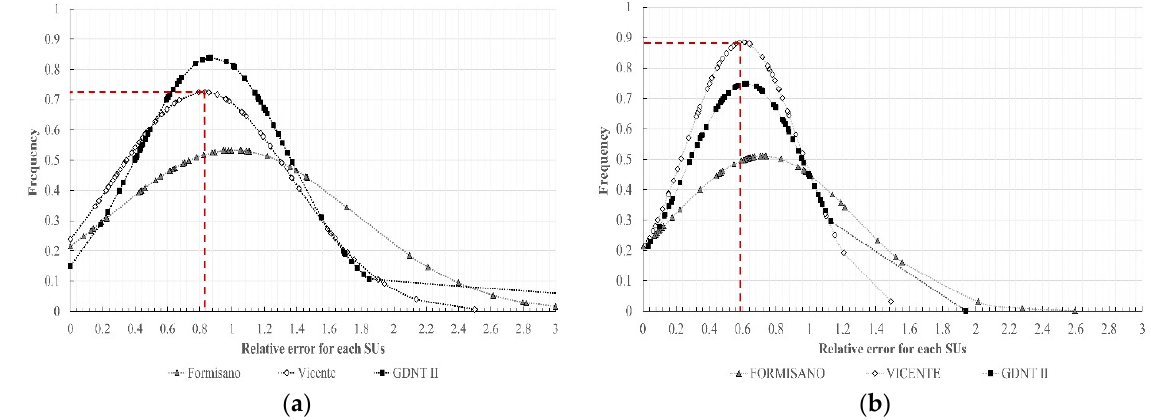
Figure 13. Relative error distribution of the I V methods obtained from ( a ) the direct measure and ( b ) the full sample range, where in red the reliability of the Vicente method is highlighted.